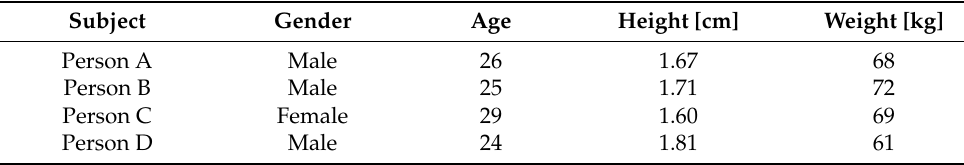
Table 3. Training subject’s physiology information.